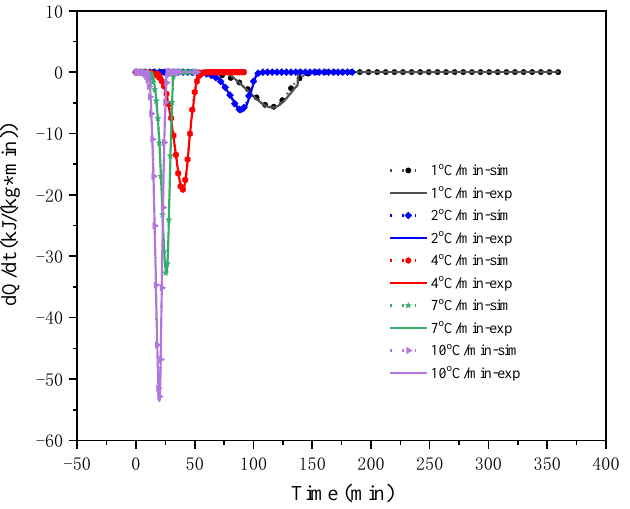
Figure 8. Evolution of heating production rate of LiTFSI-LiODFB electrolyte thermal decomposition reaction with time in experiment and simulation.